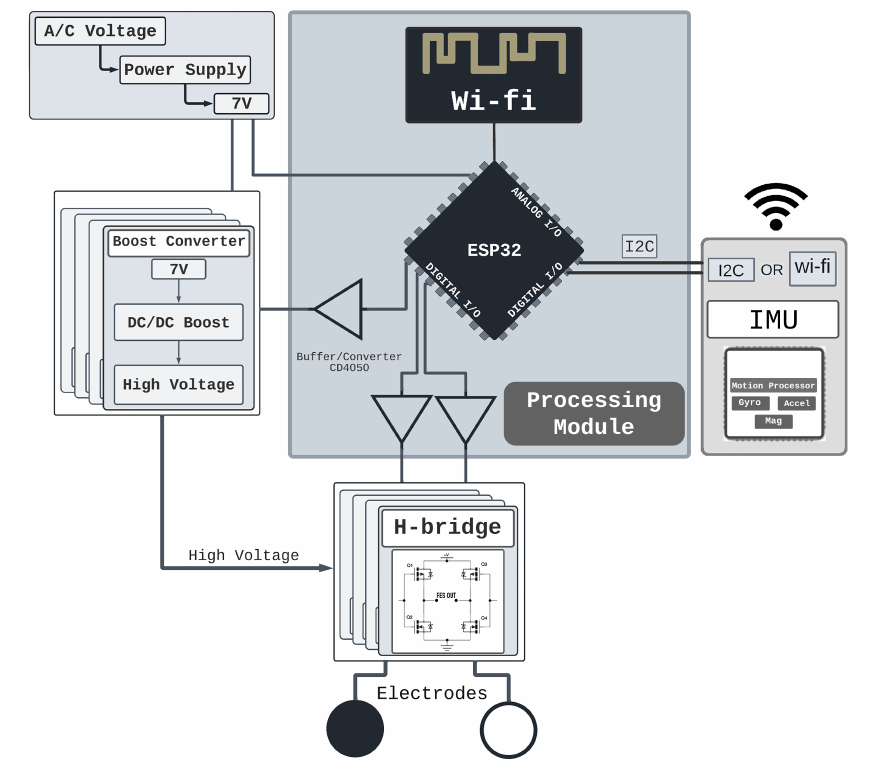
Figure 2. Hardware Architecture - The system was designed with a 7V power supply, 4 boost modules ad H-Bridges and an IMU sensor that gives feedback via I2C or Wi-Fi.